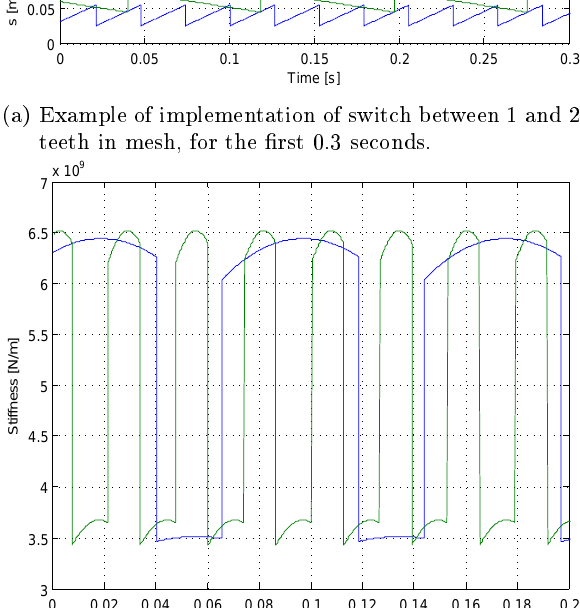
(a) Example of implementation of switch between 1 and 2 teeth in mesh, for the (cid:28)rst 0.3 seconds.